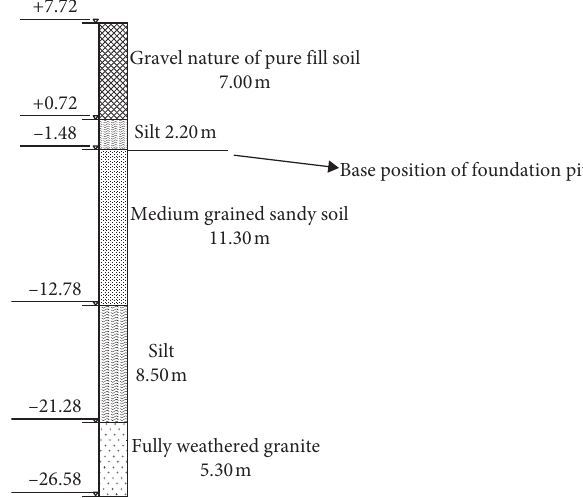
Gravel nature of pure fill soil 7.00m